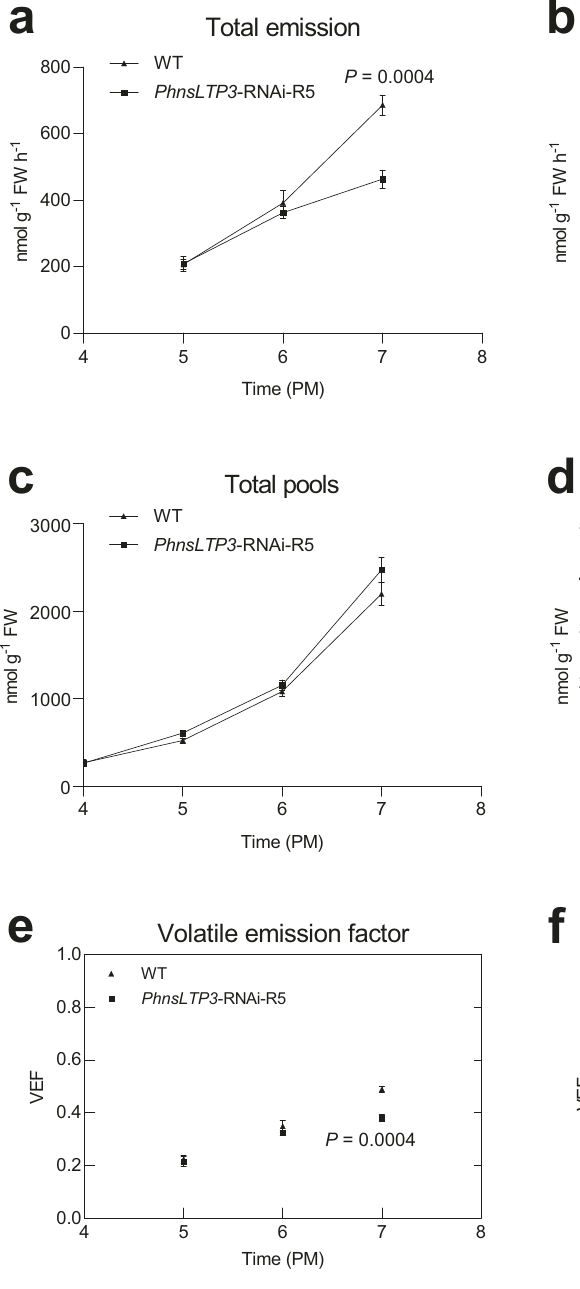
Fig. 7 | Total VOC emission, total pools, and the VOC VEFs in control and PhnsLTP3 -RNAi petunia fl owers. Total VOC emission in wild-type (WT) and PhnsLTP3 -RNAi-R5 line from 16:00 to 19:00h ( a ) and 19:00 to 22:00h ( b ). Total pools in WT and PhnsLTP3 -RNAi-R5 line from 16:00 to 19:00h ( c ) and 19:00 to 22:00h ( d ). VEFs in WT and PhnsLTP3 -RNAi-R5 line from 16:00 to 19:00h ( e ) and 19:00 to 22:00h ( f ). In a and c , data are means±S.E. ( n =9 and 5 biological repli- cates for WT and PhnsLTP3 -RNAi-R5 line, respectively, at 17:00h, 18:00h, and 19:00h, except that n =3 biological replicates for WT and PhnsLTP3 -RNAi-R5 line, respectively, at16:00h);in b and d , n =8,7 and 8 biological replicates for WT,and n =4, 5, and 5 biological replicates for PhnsLTP3 -RNAi-R5 line, respectively, at